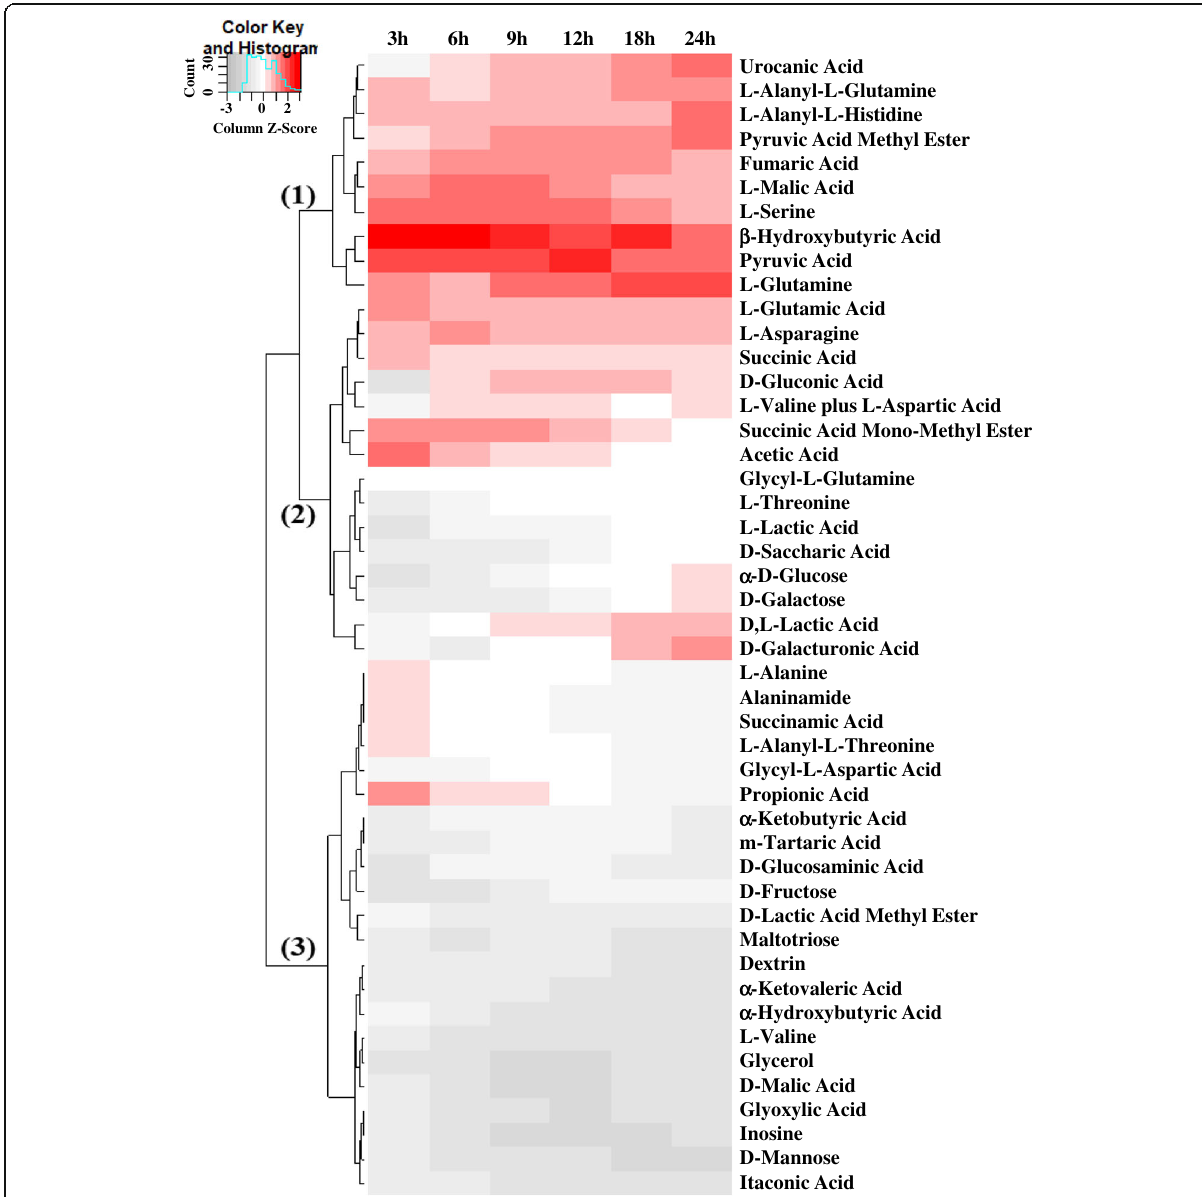
Fig. 6 Metabolic activity of Fusobacterium necrophorum . F. necrophorum KG34 isolated from dairy cows with metritis was incubated with 95 carbon sources separately. Of them, 47 metabolized by F. necrophorum at 24 h post incubation are visualized in a heat map with the scale by